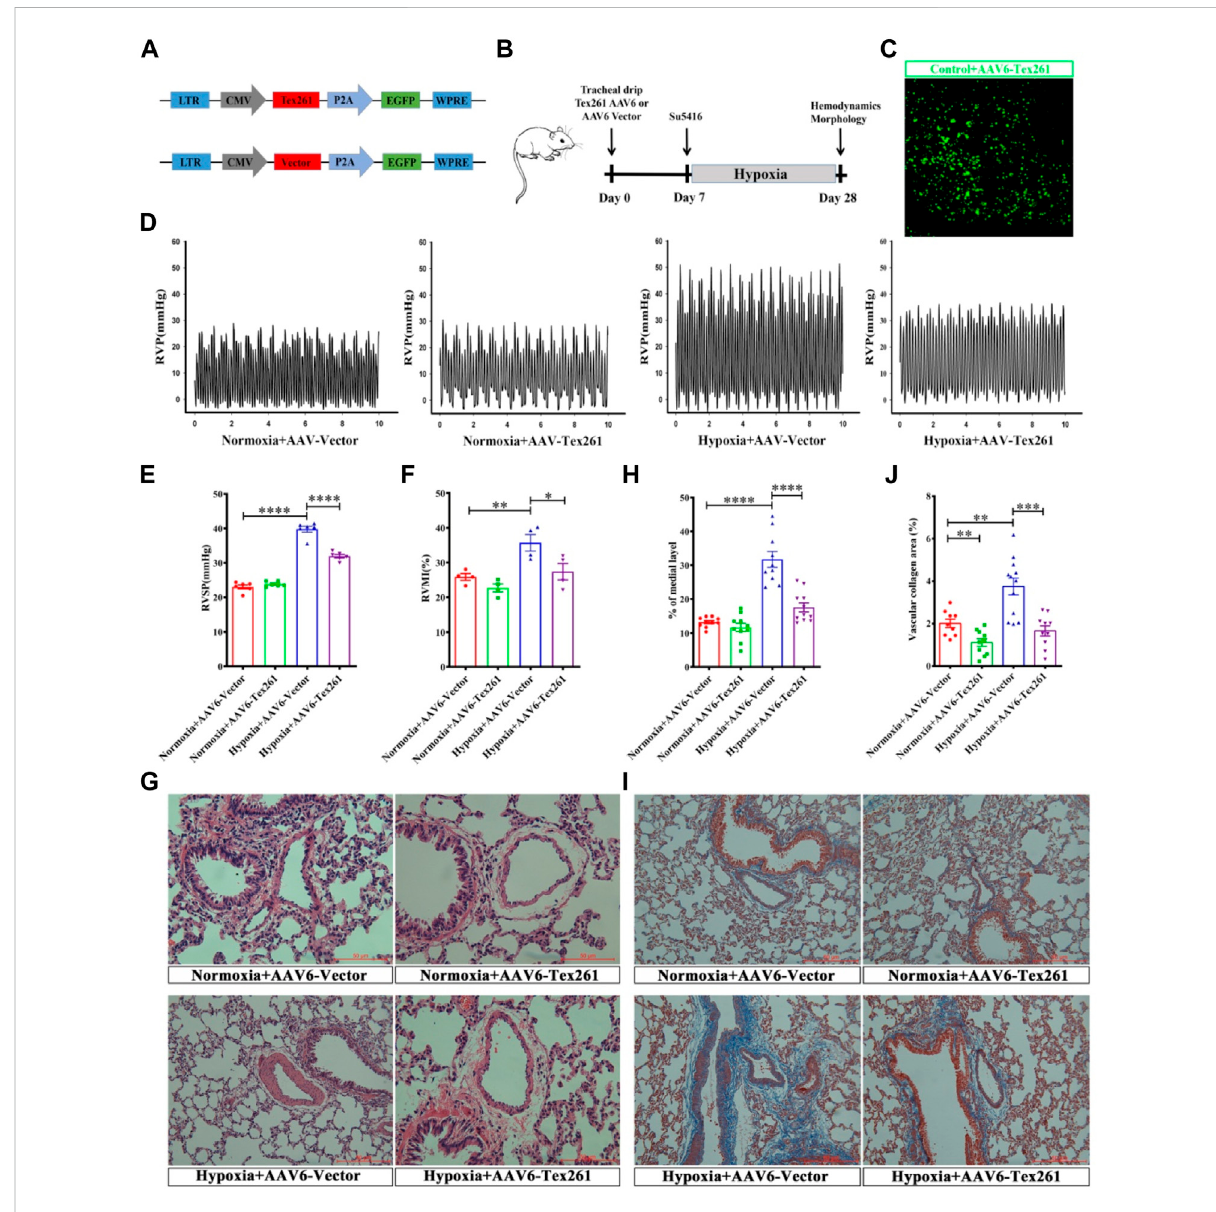
FIGURE 6 The preventative effects of Tex261 on rats with PAH. (A) Schematic diagram of the structure of the AAV6-Tex261-GFP shuttle. (B) Animal treatment protocols for the preventative effects of Tex261. After transfection of AAV6, hemodynamics and morphology were recorded after Su5416 administration at the beginning of hypoxia. (C) Veri fi cation of Tex261 transfection in lung tissues with immuno fl uorescence and observation by 10x confocal microscopy. (D – F) Representative tracings of RVP, RVSP and RVMI recorded from the control and hypoxic rats treated